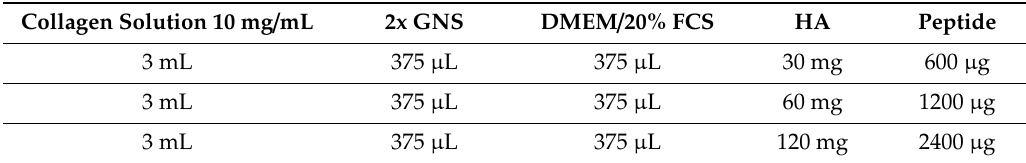
Table 1. List of components for the preparation of collagen / HA composites. GNS = gel neutralization solution; HA = hydroxyapatite.